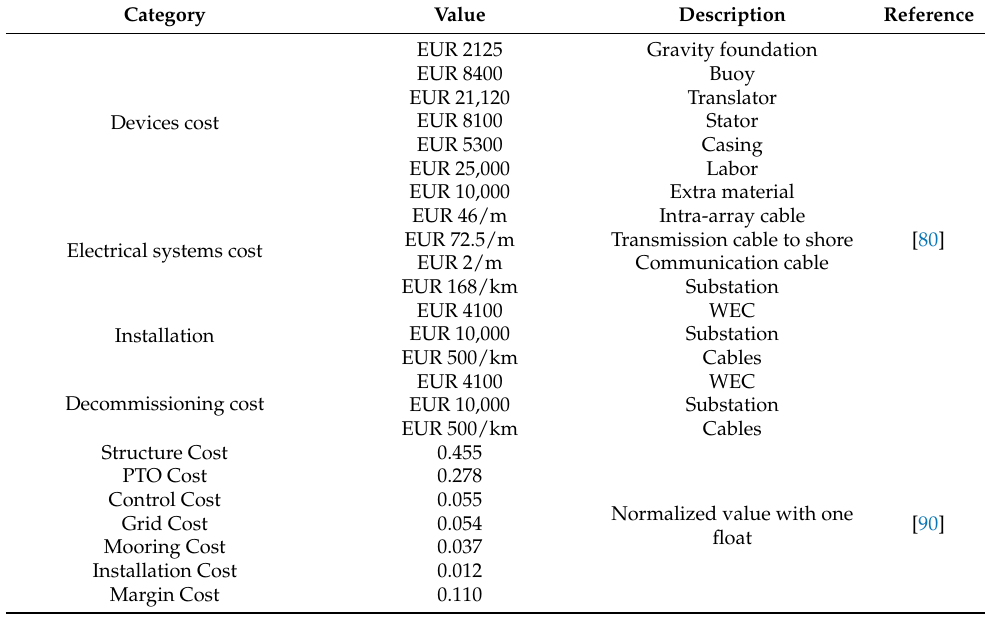
Table 3. Capital expenditure of wave